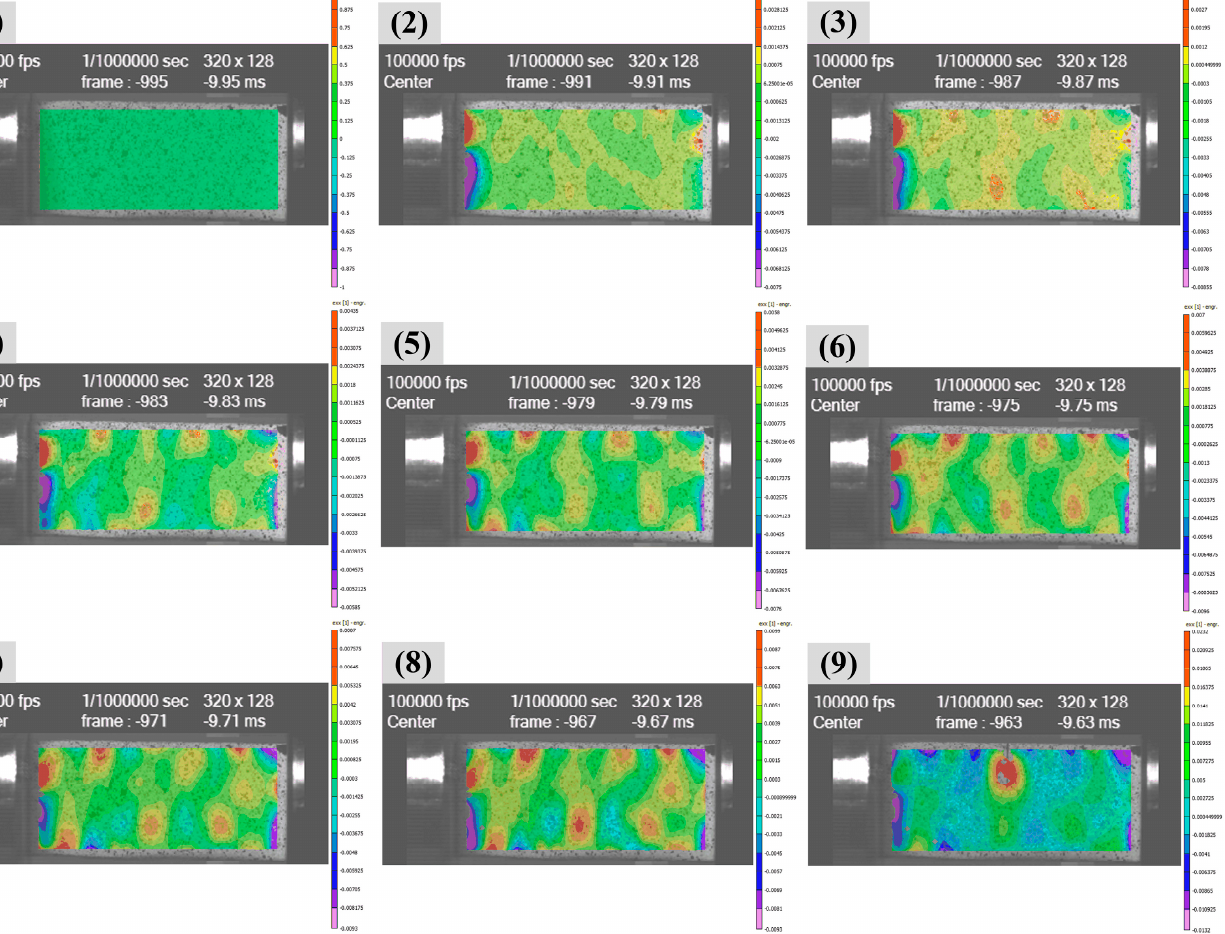
Figure 6. The strain of specimen under SHTB loading was determined by the high-speed camera DIC method. ( 1 )–( 9 ), the whole deformation process of the specimen.